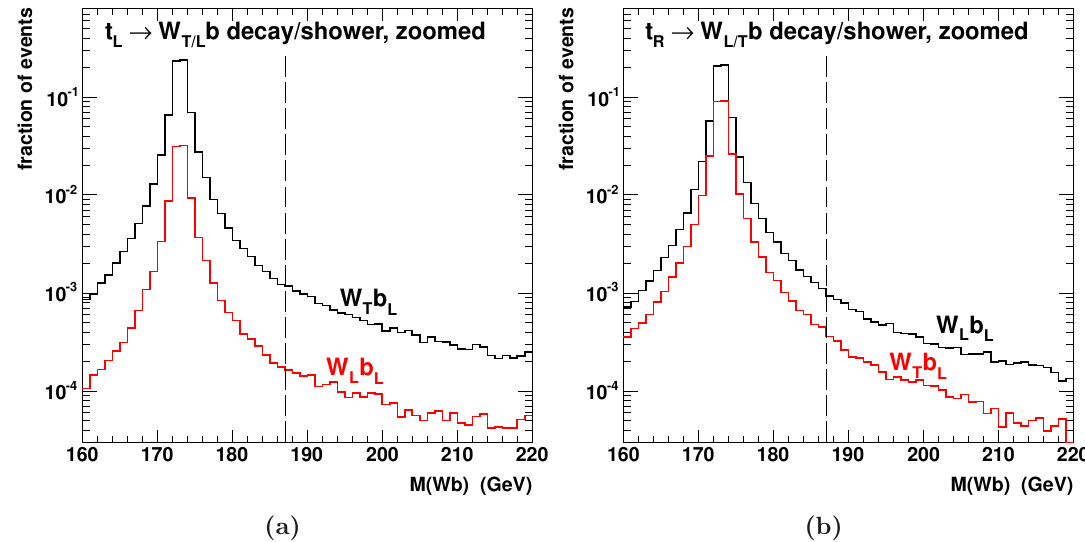
Figure 12. Invariant mass distributions for EW decay/splitting of a 10 TeV polarized top quark for (a) conventional-collinear t L W + b L and ultra-collinear t L W + b L , and (b) conventional- T L → → collinear t R W + b L and ultra-collinear t R W + b L . Decay and shower are matched at 187 GeV L T → → (vertical dashed line). The conventional-collinear contributions correspond to the upper histograms, while the ultra-collinear contributions correspond to the lower